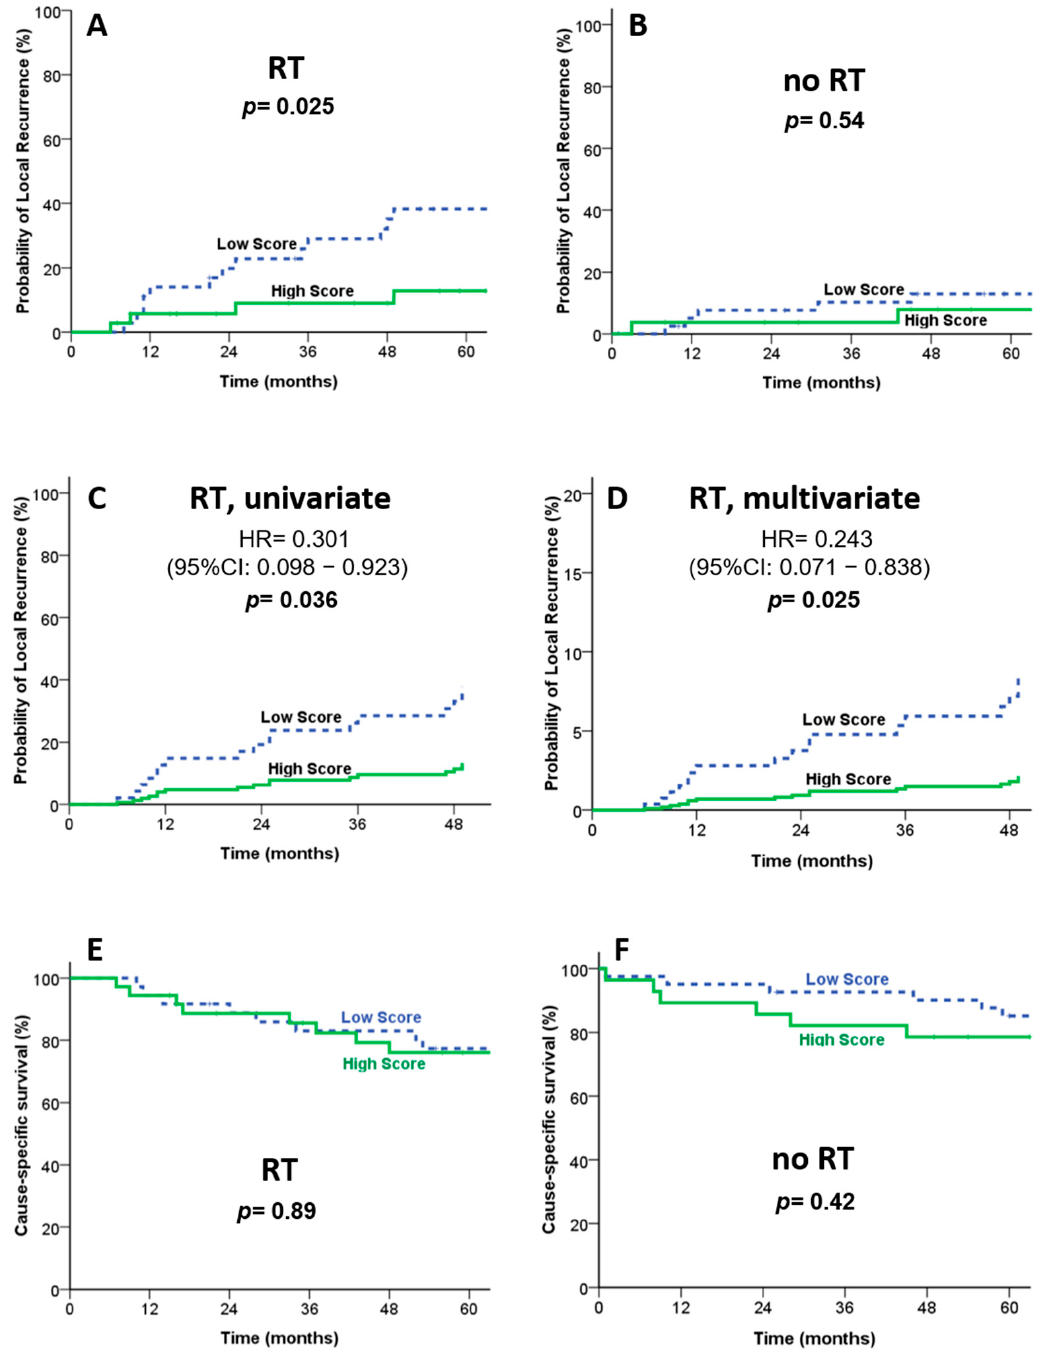
Figure 4. Clinical outcomes according to IRAK2 expression in patients treated with or without RT. ( A ) Kaplan–Meier survival curves on local control for patients treated with RT. ( B ) Kaplan–Meier survival curves on local control for patients treated without RT. ( C , D ) Cox proportional hazard regression confirmed that patients with high IRAK2 expression demonstrated better local control than those with a lower expression in univariate ( C ) and multivariate ( D ) analyses. Kaplan–Meier sur- vival curves on cause-speci fi c survival show no statistical di ff erence in the RT ( E ) and no-RT ( F ) groups.